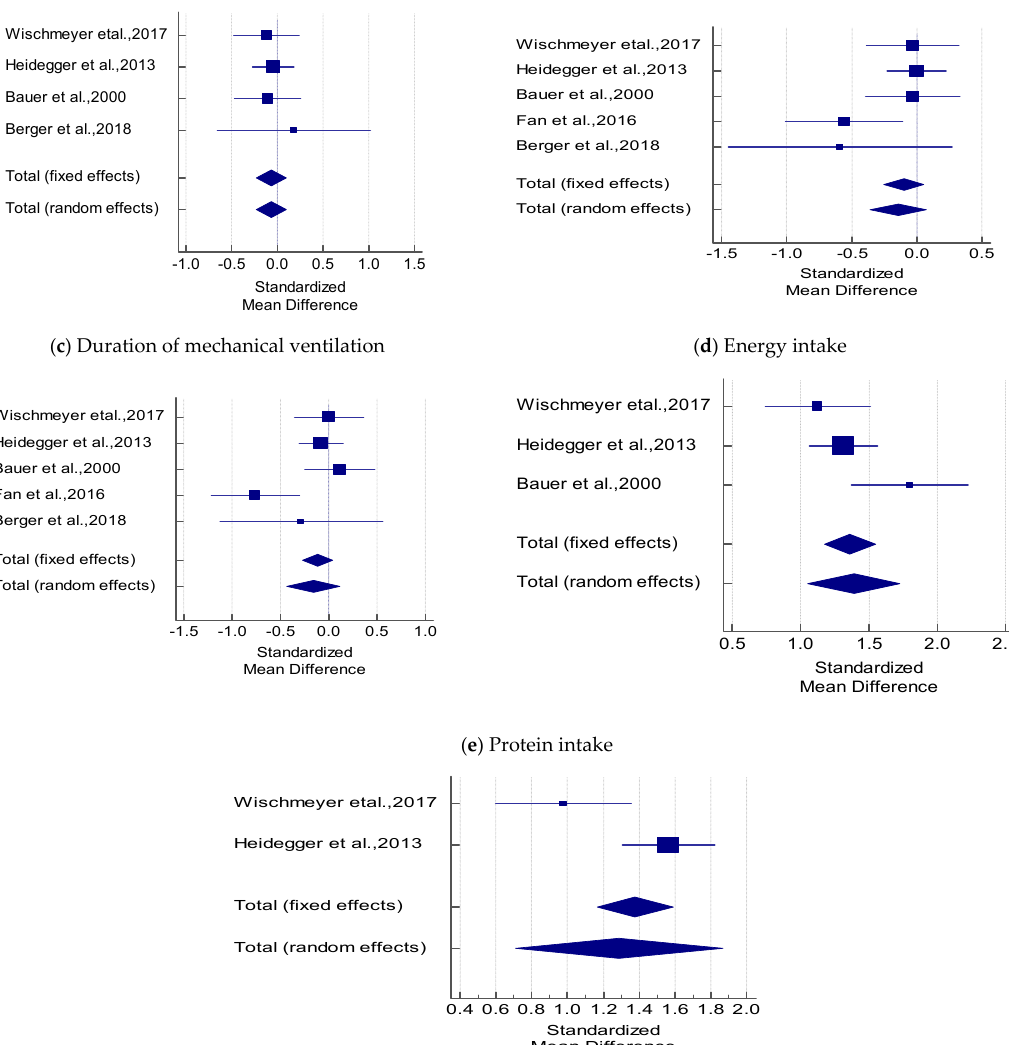
Figure 3. Forest plots comparing the effect of SPN + EN on; ( a ) Hospital stay, ( b ) Length of ICU stay, ( c ) Duration of mechanical ventilation, ( d ) Energy intake, ( e ) Protein intake.